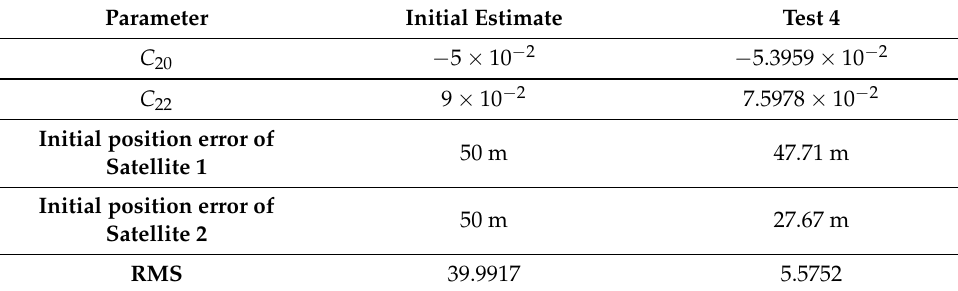
Figure 7. Residual in the observation data ( left ) and norm of the position error of the determined orbit from the true one ( right ) (test 4 with large errors in the initial estimate). Table 5. Recovery result of test